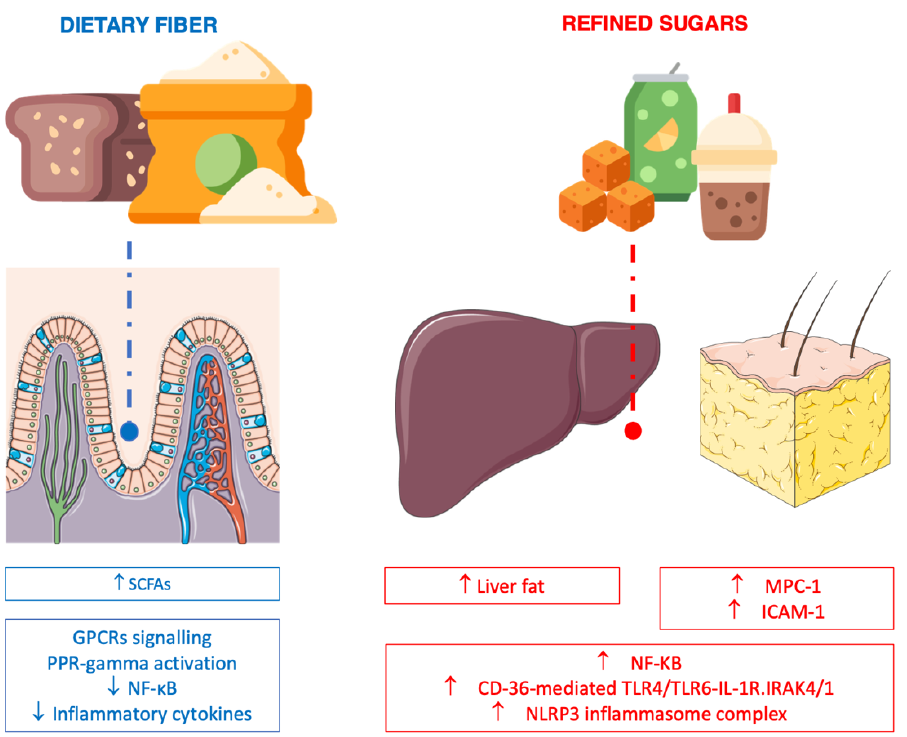
Figure 5. Mechanisms of action related to the inflammatory pathways of dietary carbohydrates. Arrows denote increment/increase or decrement/decrease.